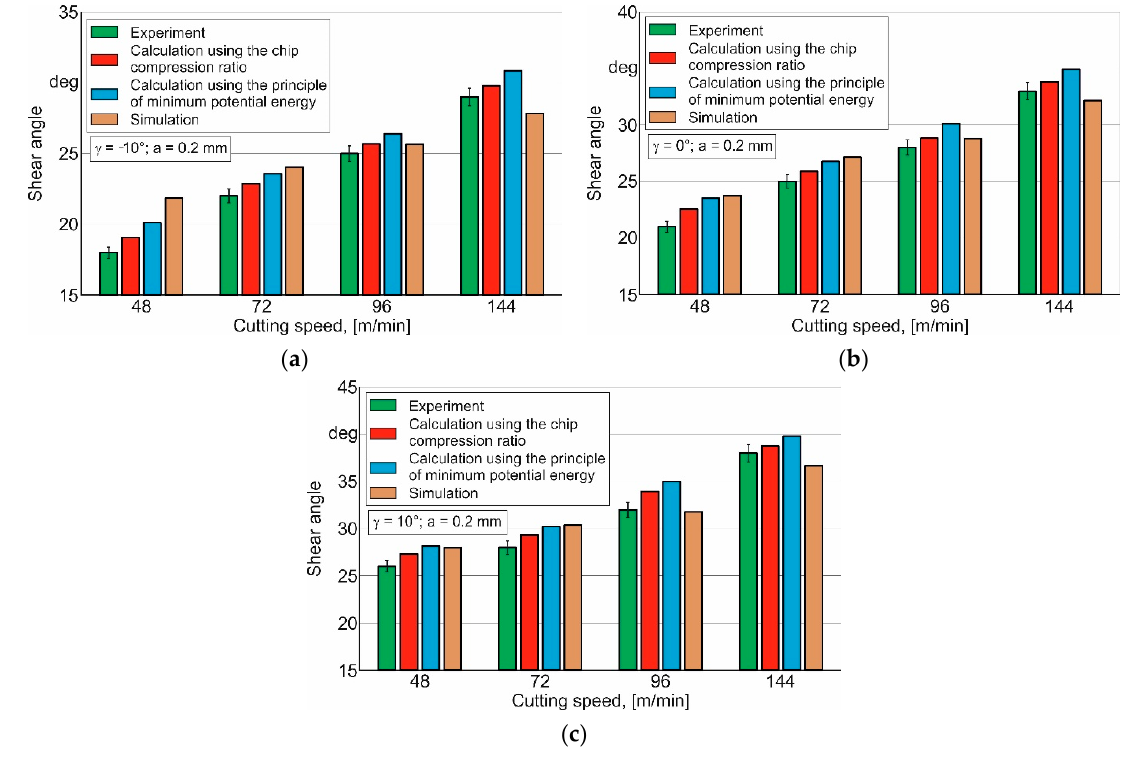
Figure 11. Comparison of experimental, calculated, and simulated shear angle values for different cutting speeds and rake angles: ( a )—tool rake angle γ = − 10°; ( b )—tool rake angle γ = 0°; ( c )—tool cutting speeds and rake angles: ( a )—tool rake angle γ = − 10 ◦ ; ( b )—tool rake angle γ = 0 ◦ ; ( c )—tool rake angle γ = 10 ◦ rake angle γ = 10°.